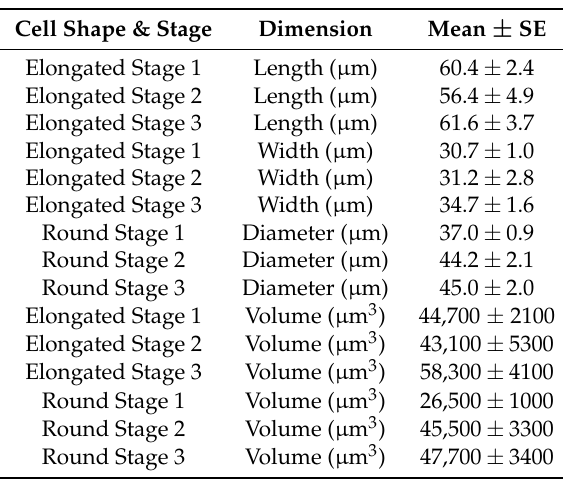
Table A1. Principal dimensions of elongated and round shaped cells. Length, width and diameter were measured from light microscopy images. Volumes were calculated using formula for a cylinder for elongated cells and a sphere for round cells. The data shown correspond to Mean ± Standard Error (SE) (n > 20).